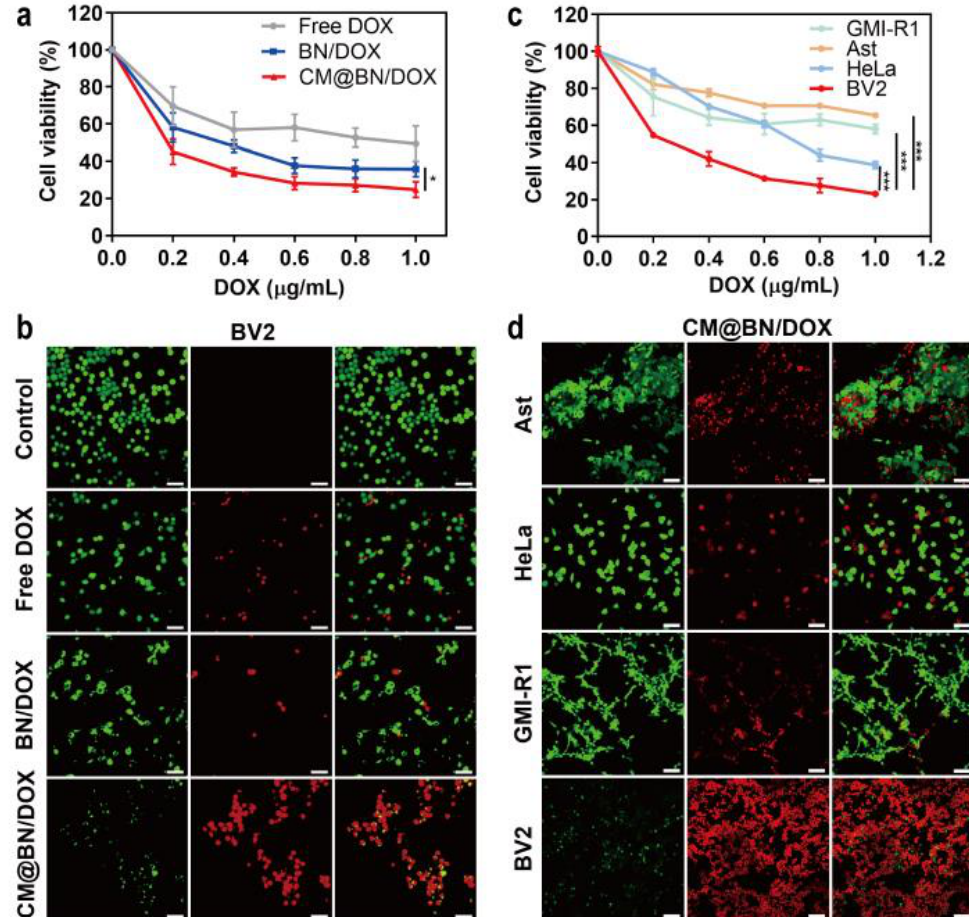
Figure 7. In vitro antitumor activity. ( a ) The viability of BV2 cells following treatment with varying concentrations of free DOX, BN/DOX, and CM@BN/DOX by the CCK-8 method. ( b ) The cytotoxicity of BV2 cells exposed to various treatments (green: living cells; red: dead cells). Scale bar = 100 µm. ( c ) The impact of varying concentrations of CM@BN/DOX on the cell viability of four different types of cells: BV2, HeLa, GMI-R1, and Ast. ( d ) The cytotoxicity of BV2, HeLa, GMI-R1, and Ast cells after treatment with CM@BN/DOX. Scale bar = 100 µm. Data are expressed as means ± SD, * p < 0.05, *** p < 0.001.